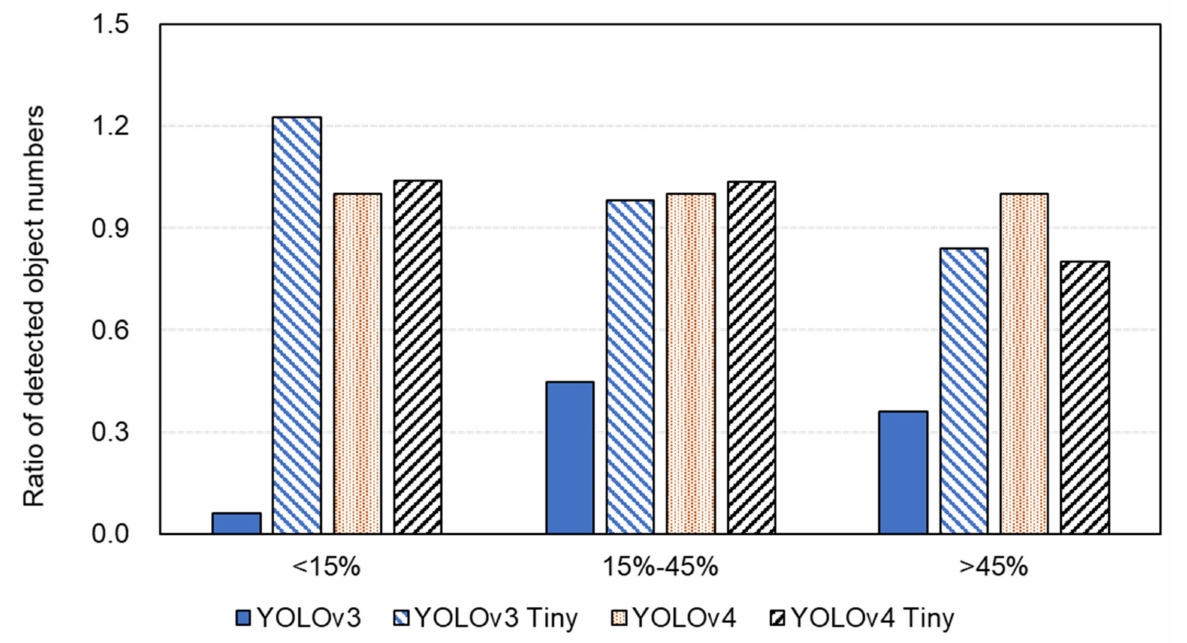
Figure 7. Comparison of the algal detection model performance with different relative object size.